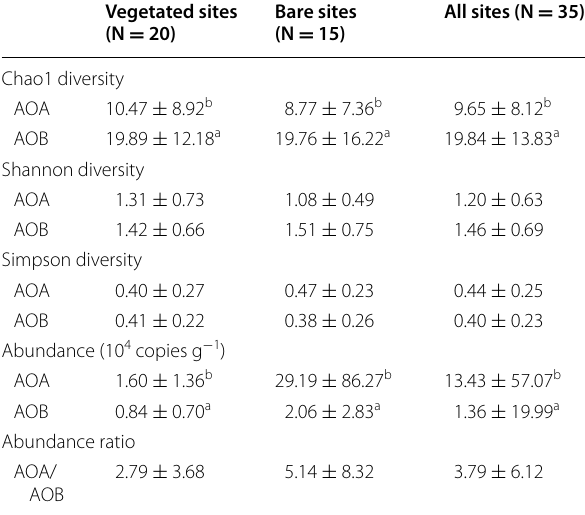
Table 2 Diversity and abundance of nitrifying archaea and bacteria in sediments from vegetated and bare sites